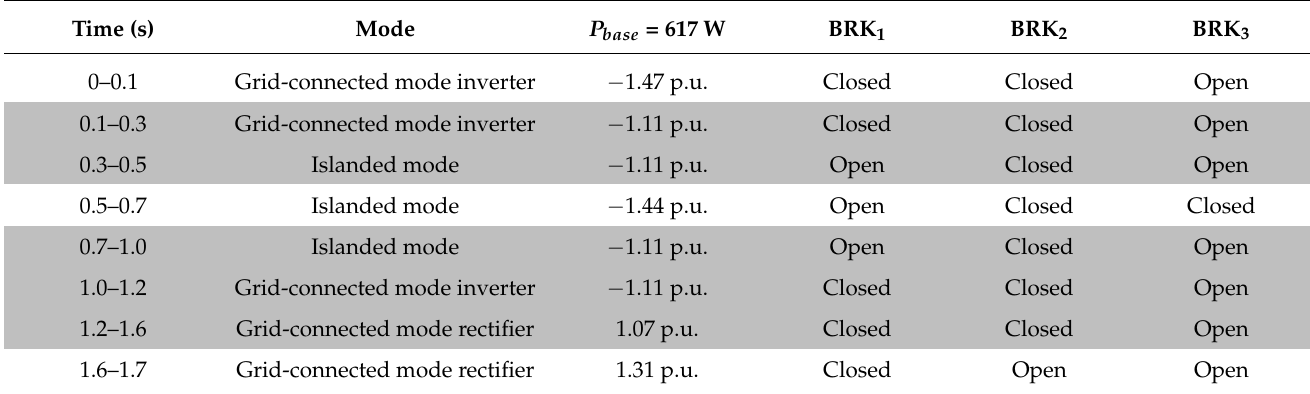
Table 7. Test protocol according to